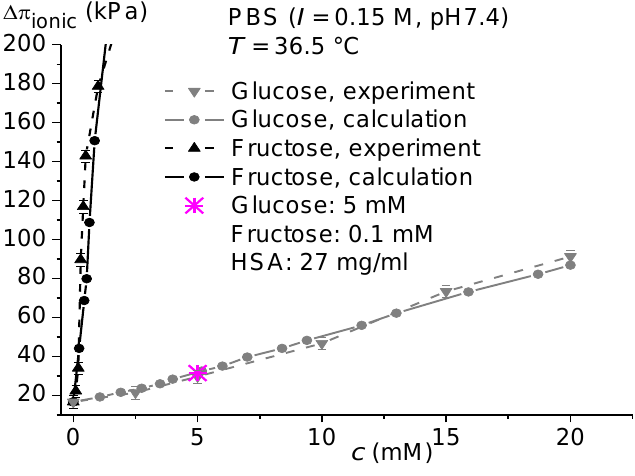
Figure 2. Response of the sensor 1 with AAm/3-AAmPBA/BIS hydrogel and corresponding calculated values of the gel swelling pressure in dependence on glucose (▼) and fructose (▲) concentration, respectively, in PBS solutions (pH 7.4, ionic strength 0.15 M) at 36.5 °C and in PBS solution with c = 5 mM, c = 0.1 mM, and c = 27 mg/mL G F HSA